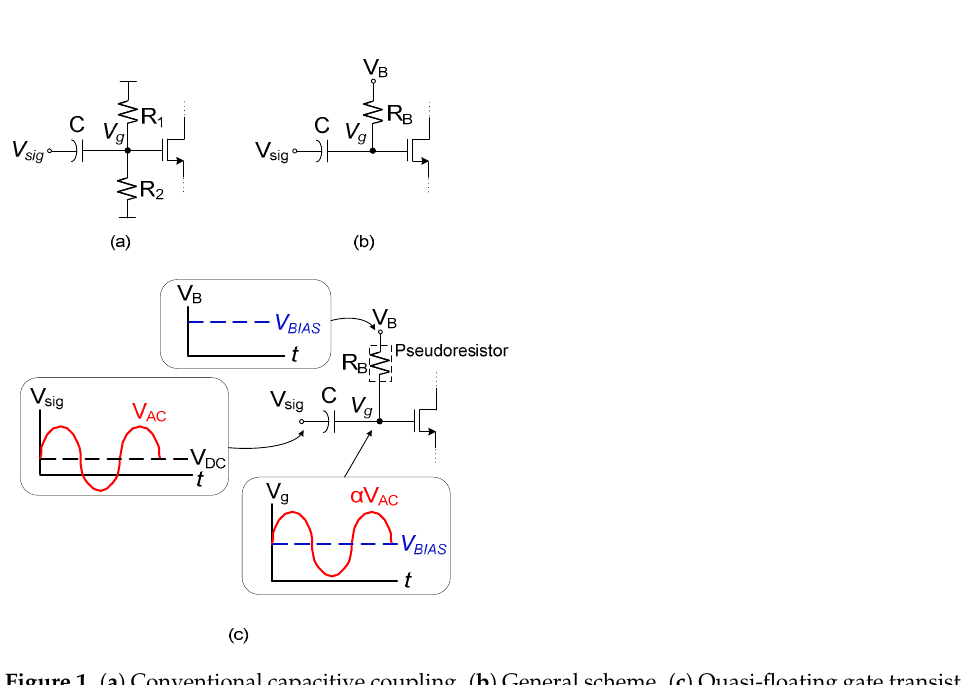
Figure 1. ( a ) Conventional capacitive coupling. ( b ) General scheme. ( c ) Quasi-floating gate transistor.